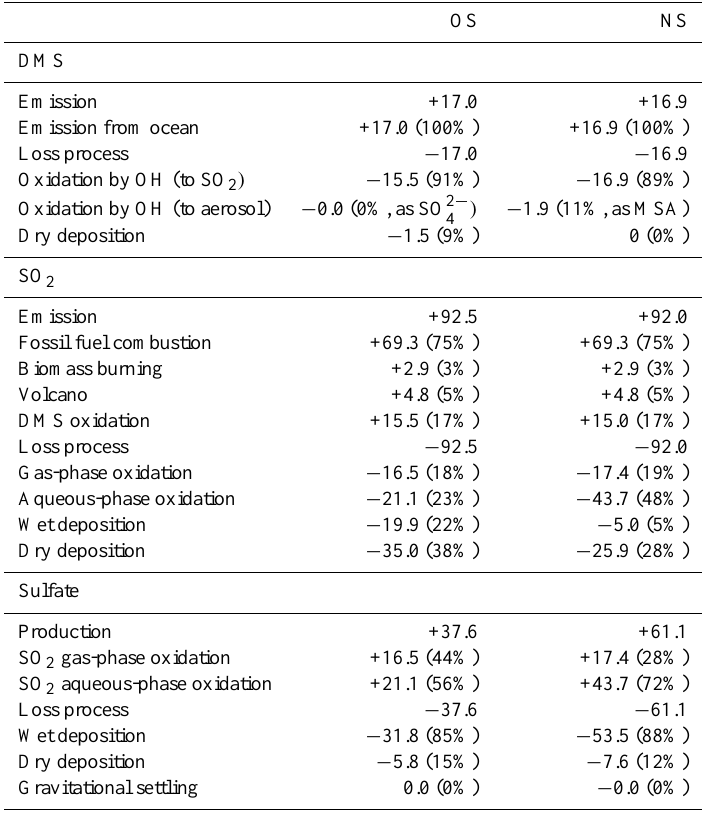
Table 5. Global budgets (TgSyr − 1 ) of sulfur components (DMS, SO 2 and sulfate) in the simulations using NS and OS. The figures in blankets represent contributions to the total budget.